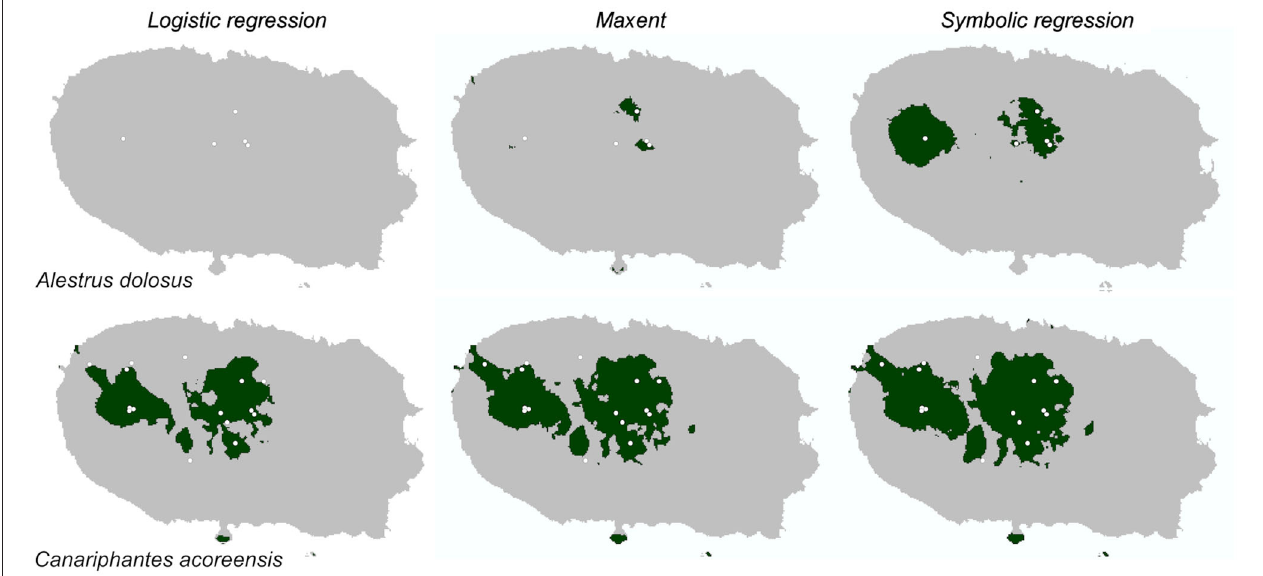
FIGURE 3 | Predicted distribution of two Azorean arthropods using three modeling methods. Observed locations (white dots) and predicted distribution (dark green areas) of Alestrus dolosus (Coleoptera, Elateridae) and Canariphantes acoreensis (Araneae, Linyphiidae) in the island of Terceira (Azores, Portugal) using logistic regression, maximum entropy, and symbolic